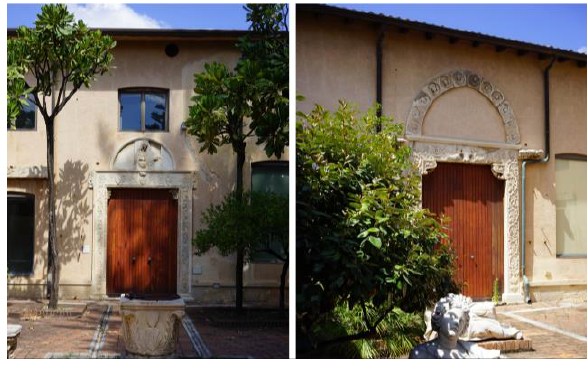
Figure 2 . The portals of Santa Maria della Scala.